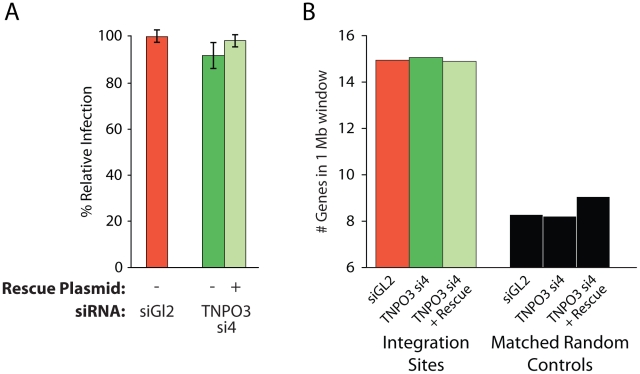
Depletion of Transportin-3 does not alter MLV integration targeting.(A) Infection levels of MLV in cells co-transfected with the control siRNA to GL2 plus an empty vector, TNPO3-si4 plus an empty vector, or TNPO3 si4 plus a vector encoding the siRNA-resistant Transportin-3 allele. (B) Average gene density in 1 Mb windows surrounding MLV integration sites in cells depleted or rescued for Transportin-3 expression. No sets showed significant differences from GL2-treated cells as determined by the Mann–Whitney test.